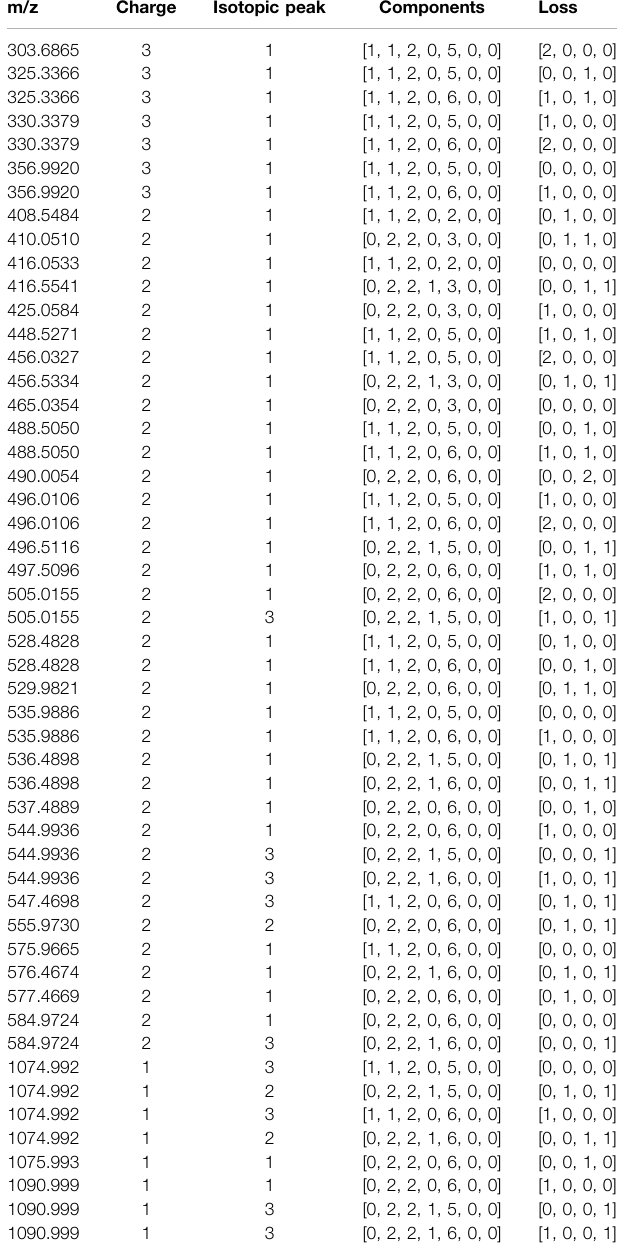
TABLE 1 | The exported detailed pro fi ling result of dp4 oligosaccharides. m/z Charge Isotopic